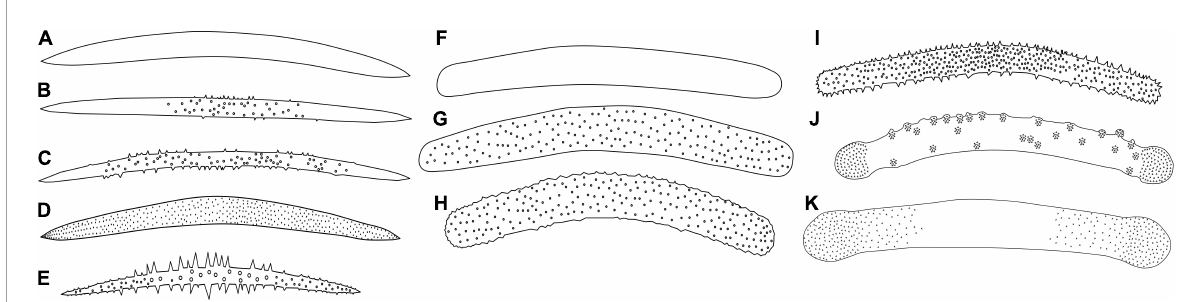
FIGURE2 Megascleres descriptors. (A) Oxea. (B) Oxea with microspines in the center of the spicule. (C) Acanthoxeas. (D) Acanthoxeas are covered with spines. (E) Acanthoxeas, covered by spines, with conical spines in the center region. (F) Smooth strongyle. (G–I) Acantostrongyle. (J) Strongyles microgranulated, the spines grouped to form spots with inflated tips. (K) Strongyles microgranulated with inflated ends.